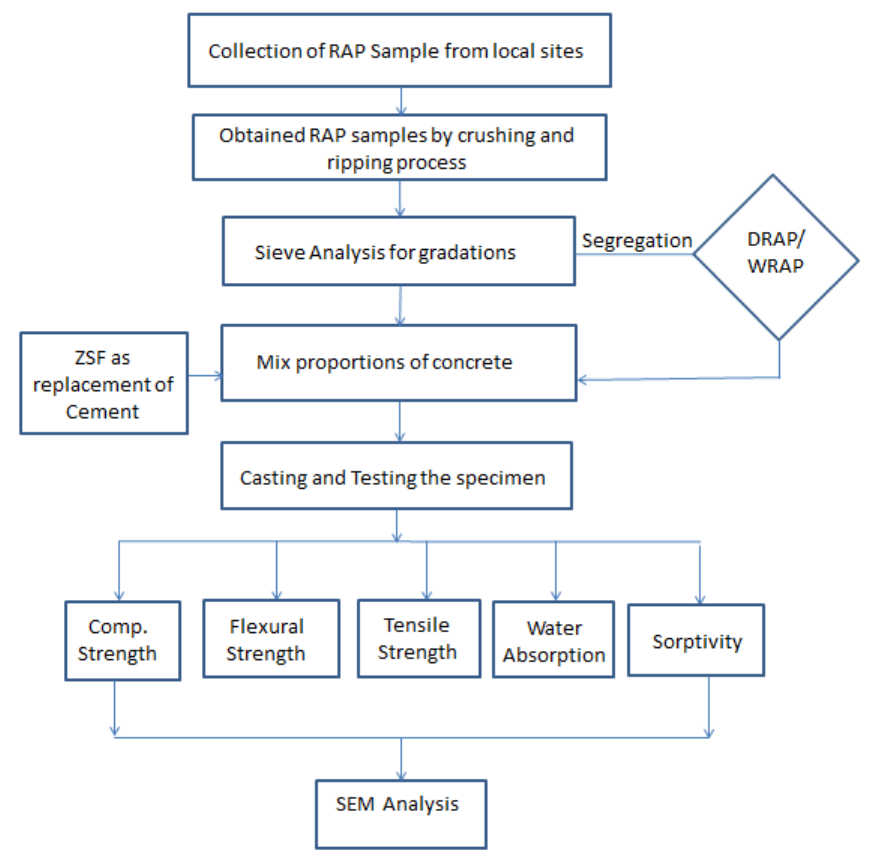
Figure 4. Flowchart for the testing procedure.